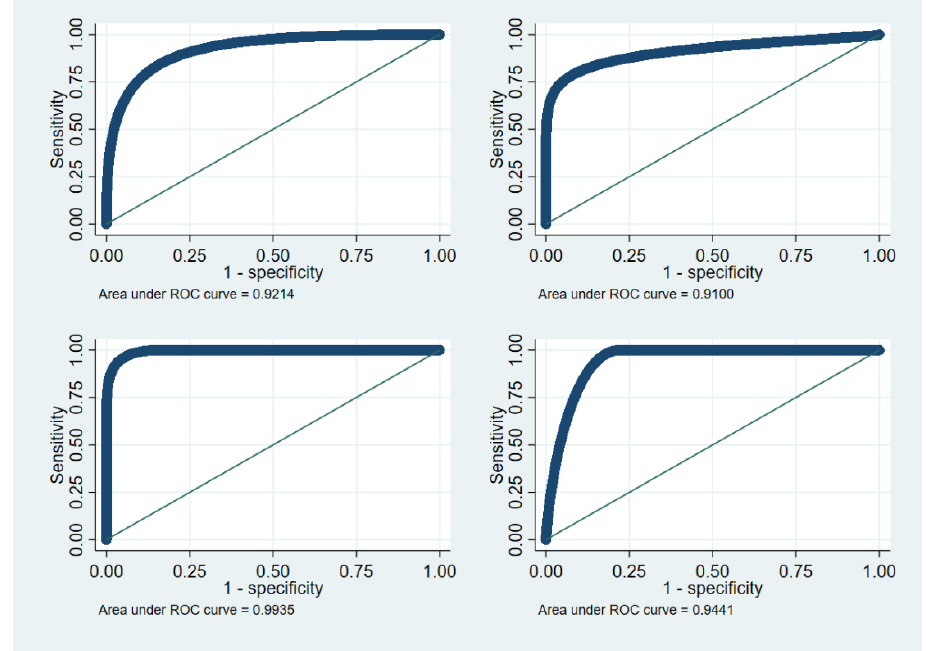
Figure A1. ROC curves of scenarios 1 ( top left ), 2 ( top right ), 3 ( bottom left ), and 4 ( bottom right ), based on 10,000,000 observations with a prevalence of 0.5.